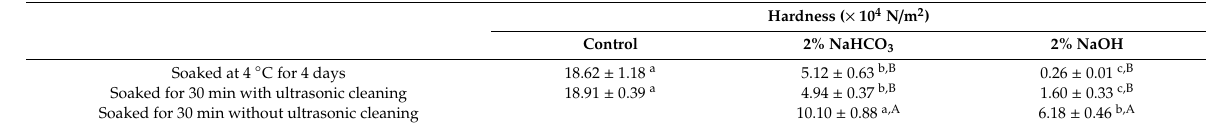
Table 1. Hardness of neritic squid muscle soaked in alkali and subjected to ultrasonic cleaning.